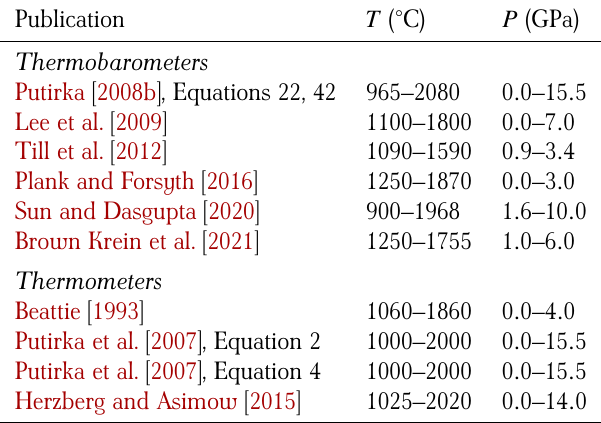
Table 1: List of thermobarometric schemes currently offered by meltPT . Equations refer to equation numbers in the listed pub- lications. All thermobarometers can be used as thermometers and barometers but some require P or T as an input parameter, respectively. For up-to-date lists of thermobarometric schemes currently implemented in meltPT , visit our online documenta- tion: https://meltpt.readthedocs.io